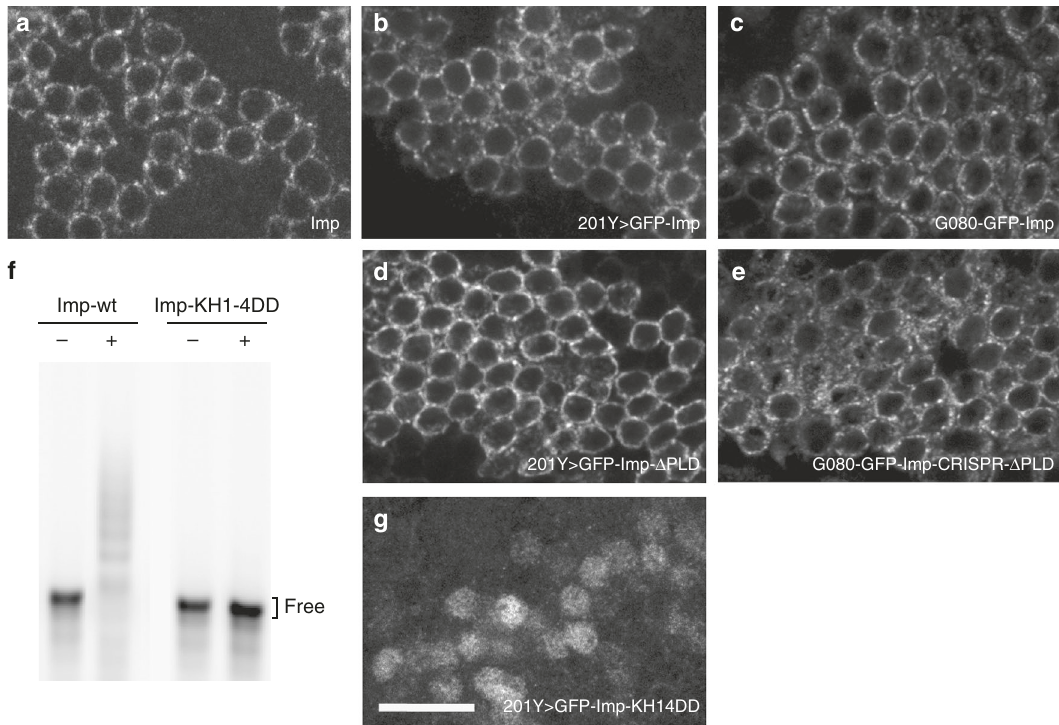
Fig. 5 Imp PLD is dispensable for RNP granule assembly. a Cell bodies of wild-type adult MB γ neurons stained with anti-Imp antibodies. b , d , g Cell bodies of adult MB γ neurons expressing wild-type GFP-Imp ( b ), GFP-Imp- Δ PLD ( d ) or GFP-Imp-KH1 – 4DD ( g ) under the control of the 201Y-Gal4 driver. Complete genotypes: 201Y-Gal4/UAS-GFP-Imp, 201Y-Gal4/UAS-GFP-Imp-KH1 – 4DD, and 201Y-Gal4/UAS-GFP-Imp- Δ PLD. c , e Cell bodies of adult MB γ neurons homozygous for the G080-GFP-Imp ( c ) or G080-GFP-Imp-CRISPR − Δ PLD ( e ) chromosomes. GFP signals are shown in white. Note that the KH1 – 4DD mutations induce an accumulation of Imp proteins in the nucleus, as described for the vertebrate protein 68 . Scale bar in a – g : 10 μ m. f EMSA analysis using fl uorescently-labeled pro fi lin 3 ’ UTR in the absence ( − ) or presence ( + ) of 800 nM recombinant GFP-Imp (left) or GFP-Imp-KH1 – 4DD